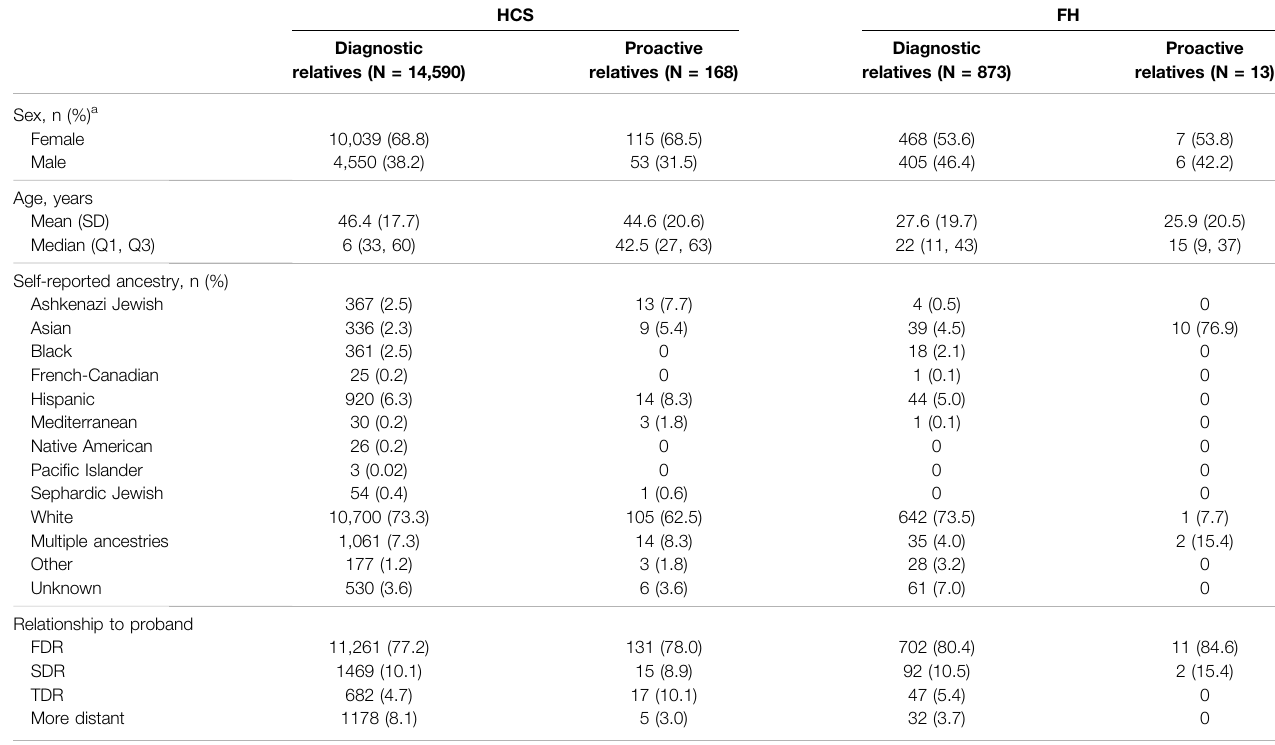
TABLE 2 | Demographic information of